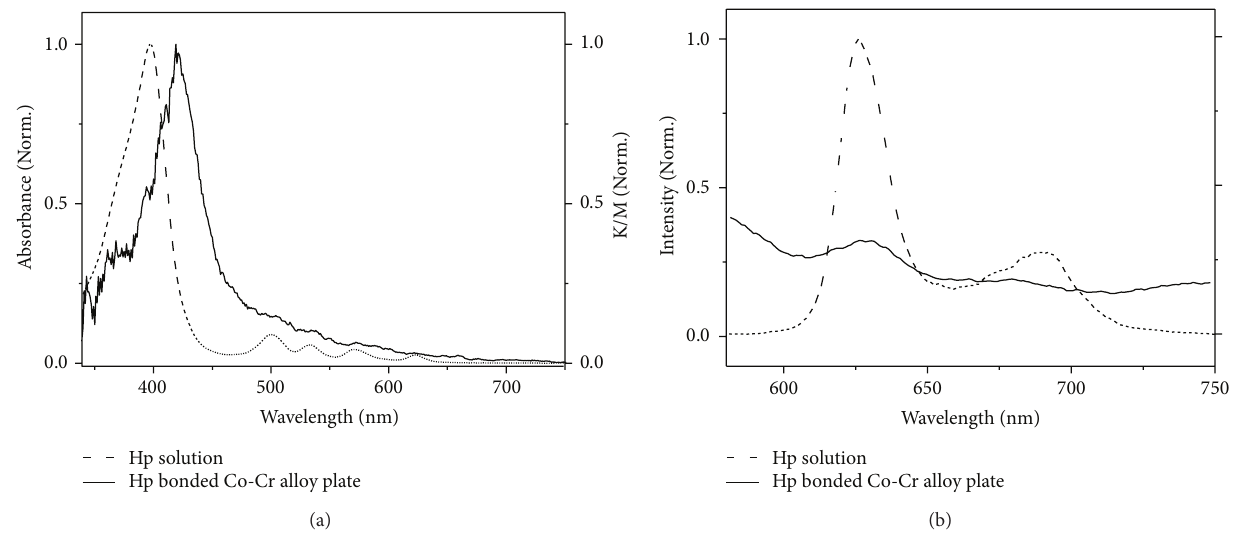
Figure 3: (a) Absorption and (b) emission spectra of Hp in EtOH (dashed line) and of the Hp bonded to Co-Cr alloy plate (solid line).